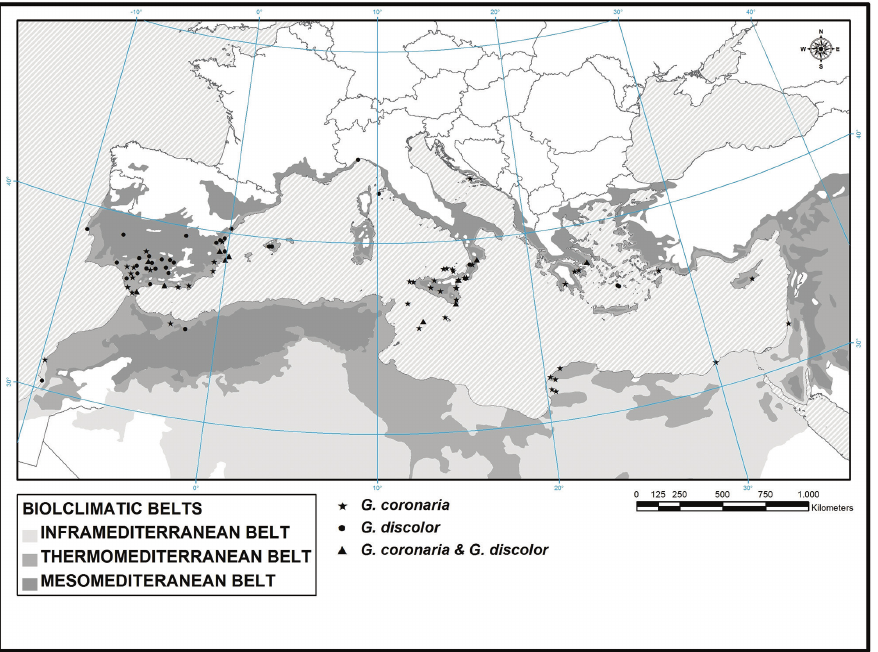
Figure 8. Thermoclimatic distribution of Glebionis coronaria (thermo-Mediterranean) and G. discolor (thermo and meso-Mediterranean) selected samples